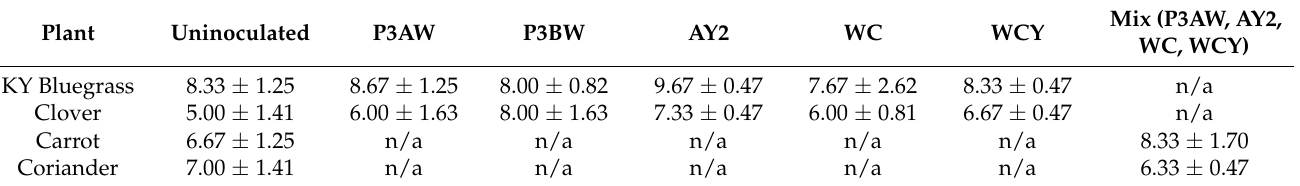
Table A1. Average number of seeds germinated per magenta box by plant host and by inoculated strain. Each box contained a total of 10 seeds. ± refers to standard deviation.